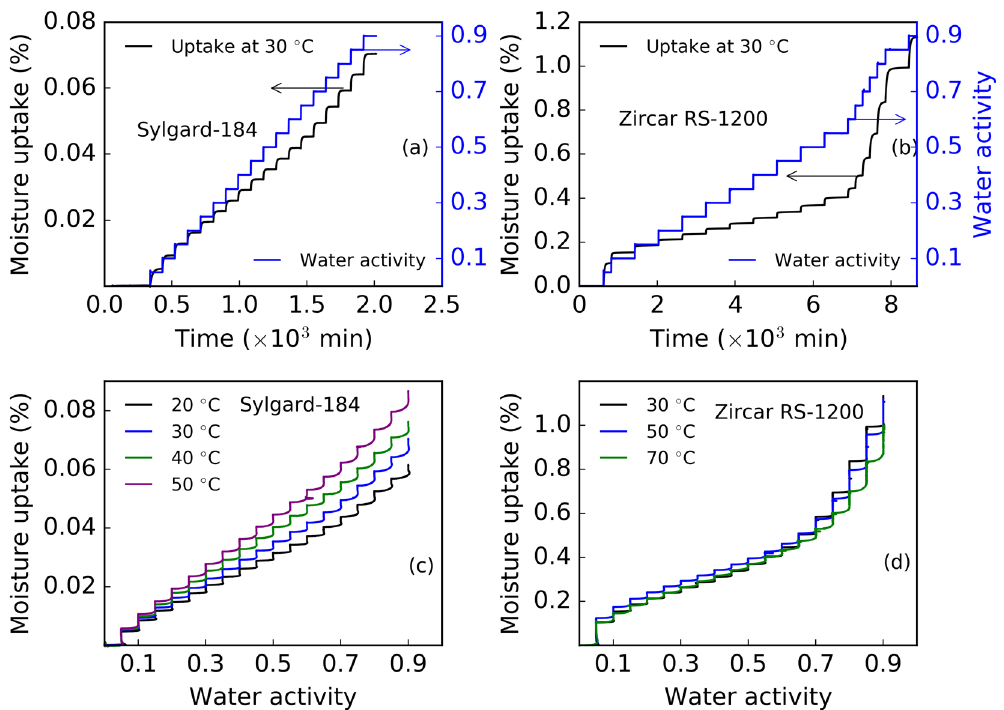
Figure 1. Typical moisture uptake (in %) vs. time (in minutes) or water activity profile for Sylgard-184 and Zircar RS-1200. Panel a: moisture uptake (in %) vs. time for Sylgard-184 at 30 °C, Panel b: moisture uptake (in %) vs. time for Zircar Rs-1200 at 30 °C, Panel c: moisture uptake (in %) vs. water activity for Sylgard-184 at 20, 30, 40, and 50 °C, Panel d: moisture uptake (in %) vs. water activity for zircar RS-1200 at 30, 50, and 70 °C. Water vapor activity from 0 to 0.9 corresponds to the relative humidity range of 0 to